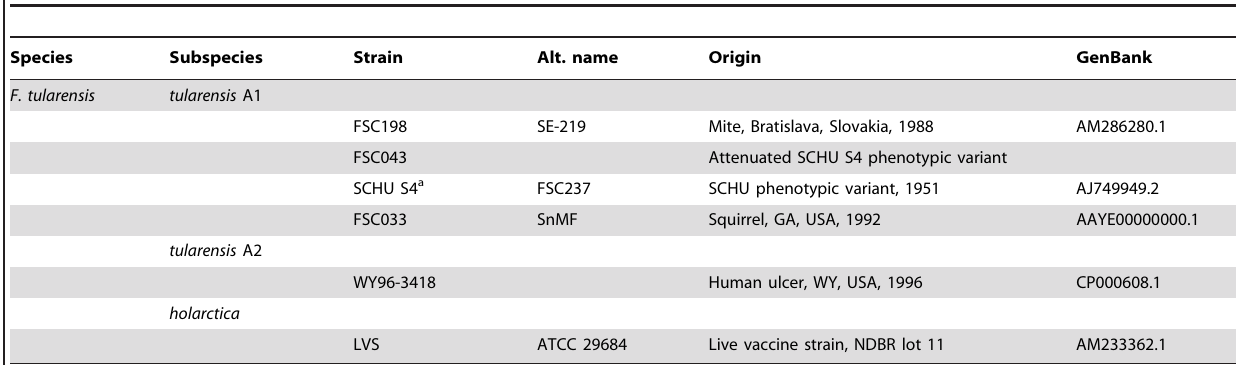
Table 2. F. tularensis genome sequences used in this